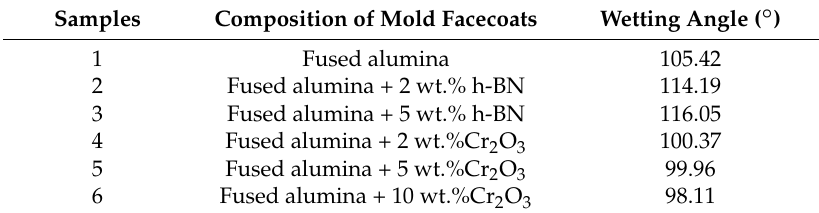
Figure 10. Mold facecoat samples for sessile drop test. ( a ) Before test; ( b ) during testing and ( c ) after test (1-fused alumina; 2-fused alumina + 2 wt.% h-BN; 3-fused alumina + 5 wt.% h-BN; 4-fused alumina + 2 wt.% Cr 2 O 3 ; 5-fused alumina + 5 wt.% Cr 2 O 3 ; 6-fused alumina + 10 wt.% Cr 2 O 3 ). Table 3. Wetting angles of alloy melt on the mold facecoats.